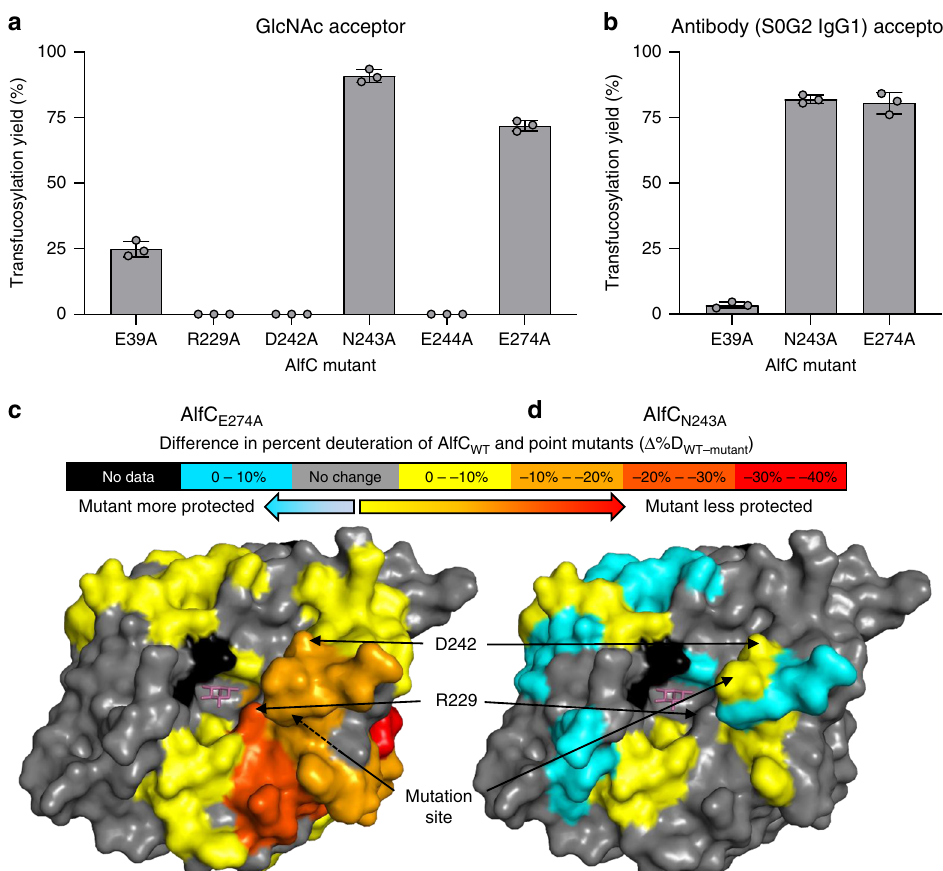
Fig. 6 Analysis of AlfC transfucosylation mutants. a AlfC catalyzed transfer of fucose from α -fucosyl fl uoride; and b IgG1 antibody (S0G2 glycoform). Separate reactions were measured with error bars representing standard deviation of n = 3 independent experiments. Data are presented as mean values ± SEM. c , d Hydrogen – deuterium exchange mass spectrometry analysis of transfucosylation mutants. Maximum differences in percent deuteration of peptides at 10 s or 1 min from c AlfC E274A and d AlfC N243A compared to wild-type. Differences are mapped onto a surface representation of AlfC bound to fucose (magenta). The site of mutation and the position of D242 are annotated with arrows. Source data are provided as a Source Data fi